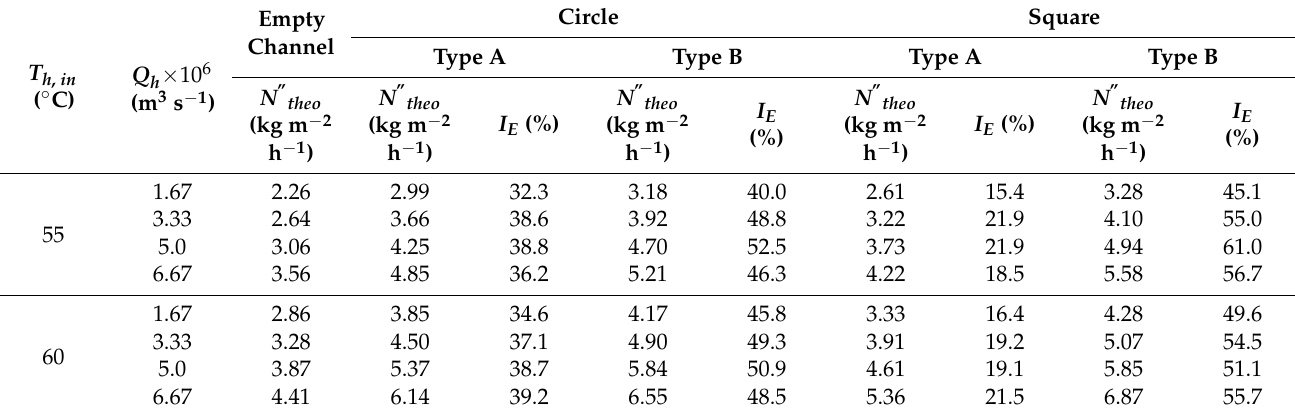
Table 2. Effects of geometric shapes and array patterns on flux enhancement for countercurrent